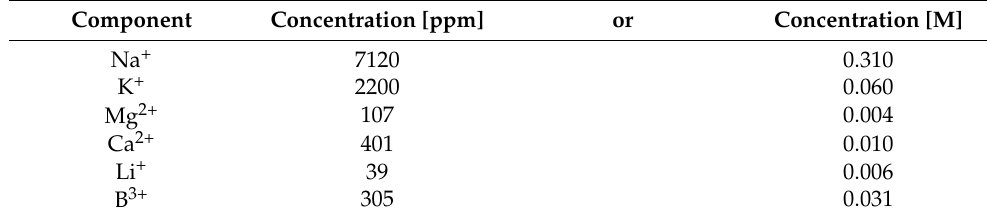
Table 1. Synthetic brine geothermal composition. Component Concentration